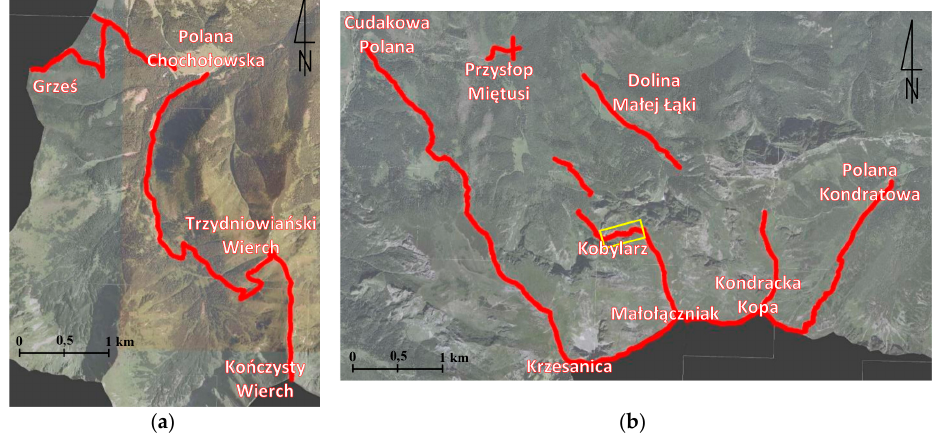
Figure 2. Hiking trails in the Western Tatras which are the subject of this research: ( a ) western part of the research area, ( b ) eastern part of the research area (source: own study based on [61]).